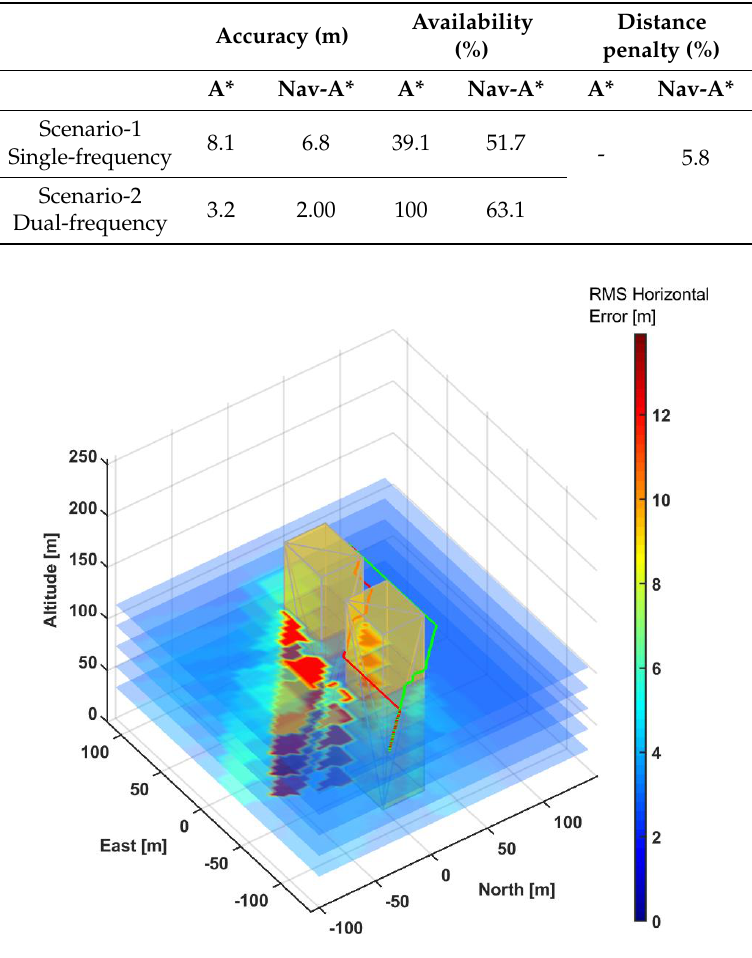
Figure 11. HRMS accuracy field along with baseline A* and Nav-A* trajectories.